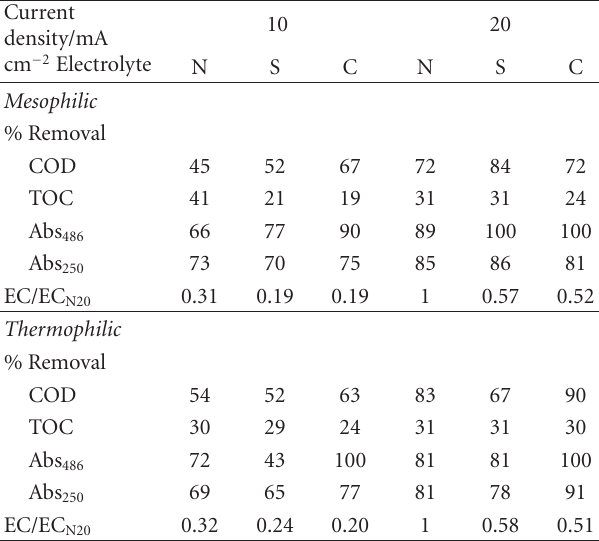
Table 3: Removals of COD and TOC, Absorbance at 468 nm (AO7) and 250nm (Arom), and relative current e ffi ciency obtained after the electrochemical degradation of the e ffl uents from the UASB reactors